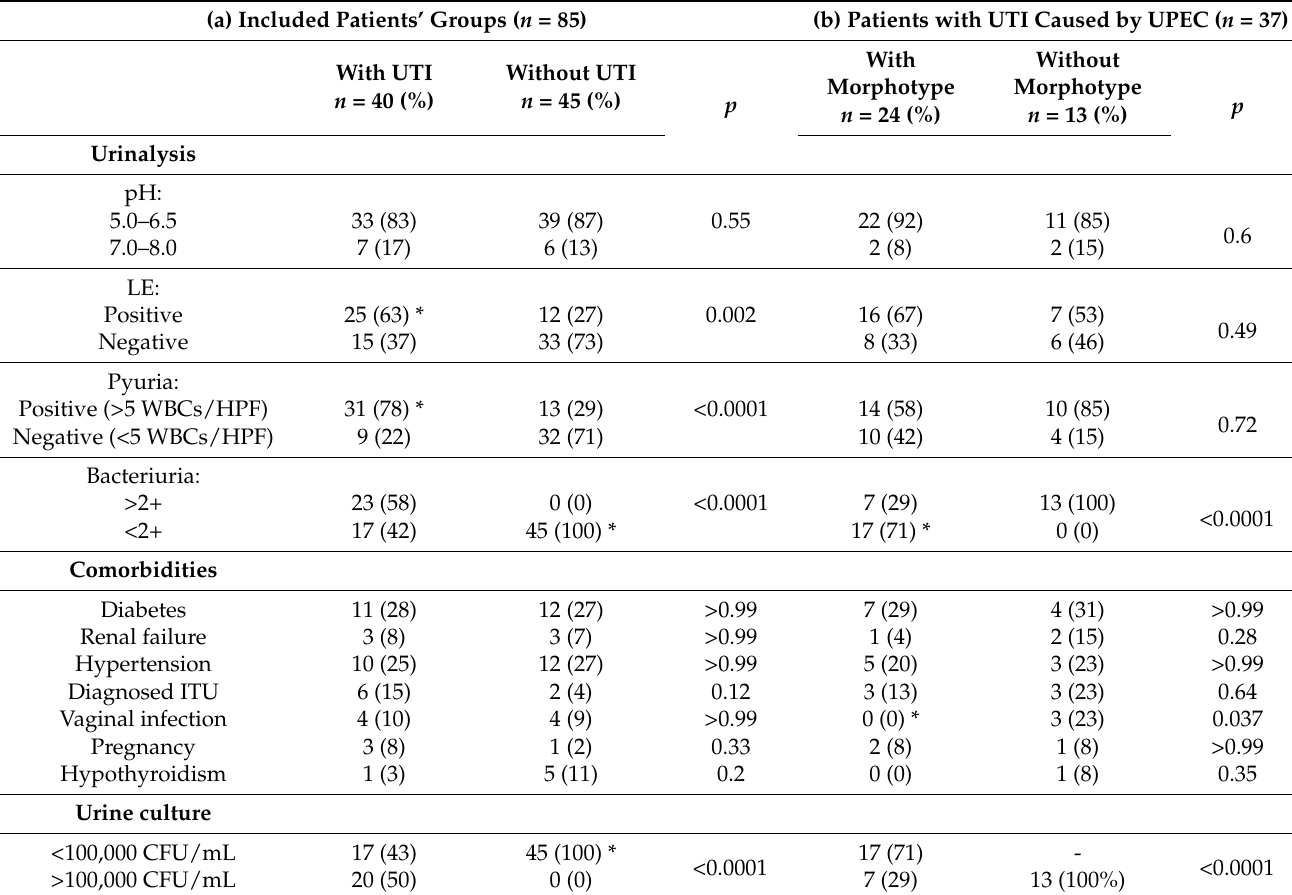
Table 2. Urinalysis, comorbidities, and urine culture